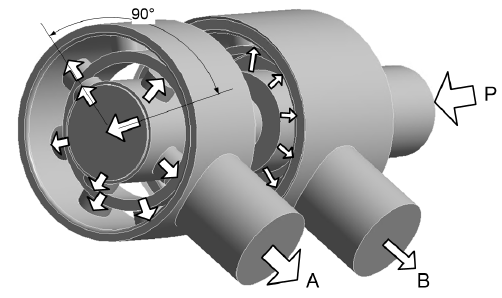
Figure 3. Model of the working fluid; P, A, B—connection